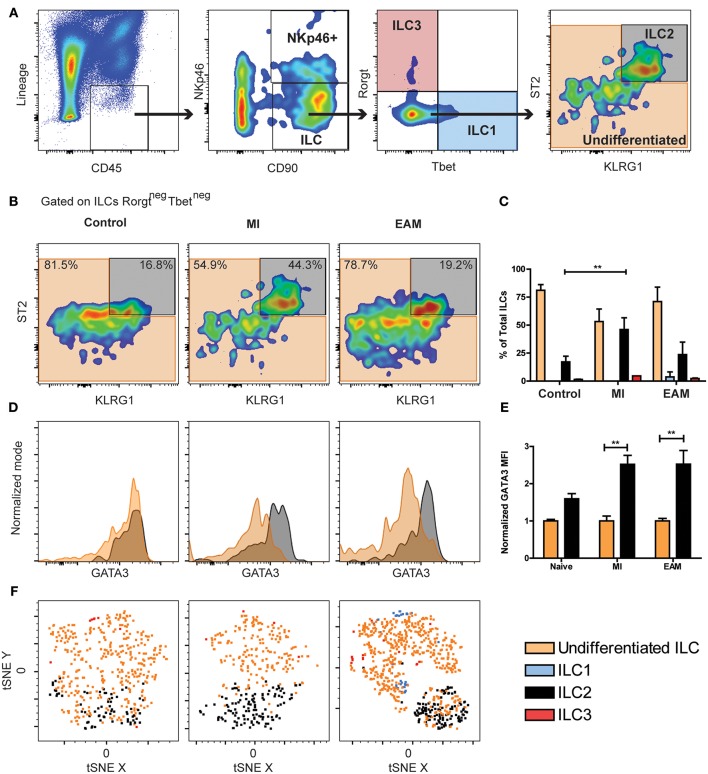
Undifferentiated ILCs are predominant in naïve mice hearts, while the ILC2 compartment expands during MI and EAM. (A) Mouse cardiac ILCs gating strategy, defining ILCs as CD45+LineagenegCD90+, CD11bneg NK cells and NKp46+ ILC3s as CD90+NKp46+, non-cytotoxic ILC1s (blue) as Tbet+, ILC2s (gray) as ST2+KLRG1+GATA3int−high, ILC3s (transparent red) as Rorγt+. Undifferentiated ILCs (transparent orange) as ILCs negative for all ILC type-specific markers. (B) Representative flow cytometry plots show median examples of the profile of undifferentiated ILCs and ILC2s in naïve, MI and EAM hearts gated on Rorγtneg Tbetneg ILCs. Frequency of ILC types in naïve, MI, EAM hearts. (D) Representative flow cytometry histograms show GATA3 expression on ILC2s (black) and undifferentiated ILCs (orange). (E) Normalized GATA3 MFI in naïve, MI, and EAM hearts. (F) tSNE analysis shows ILC2 clustering (black) within the undifferentiated population (orange). Plots, including tSNE analyses, show concatenates of all mice in each group of 1 of 3 independent experiments (n = 4–5 group / experiment). Bar graphs shows Mean and SD. Statistics for (C,E) calculated by Dunnett's test. **P < 0.01.